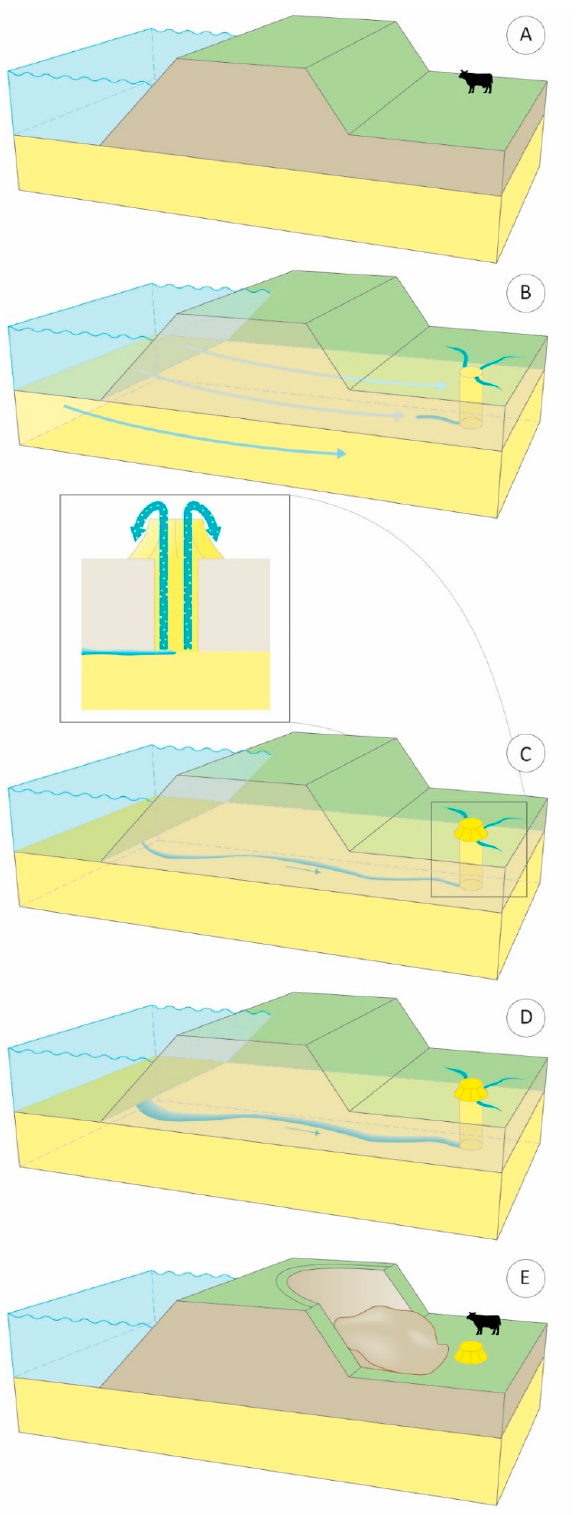
Figure 1. Several stadia of the piping process. From top to bottom: ( A ) Rise of the water level in the river increases the hydraulic head gradient over the river. ( B ) A boil forms at the outflow point and entrained sediment is expelled, forming a pipe that erodes in the direction of the groundwater flow origin. ( C ) Pipe connects to the river, creating a direct path between the river and the outflow point. ( D ) Direct connection between the river and the outflow point allows for deepening and widening of the pipe. ( E ) Increased instability due to the undermining of the dike leads to a slump type failure.